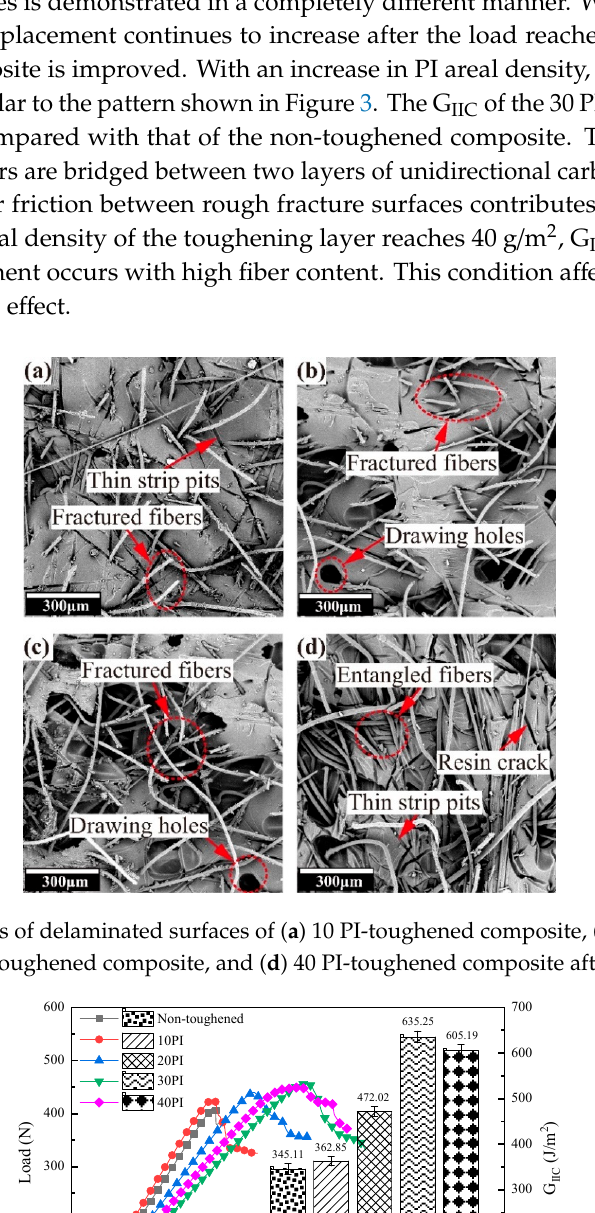
Figure 5. Load–displacement curves and Mode II interlaminar fracture toughness for 10 PI-, 20 PI-, 30